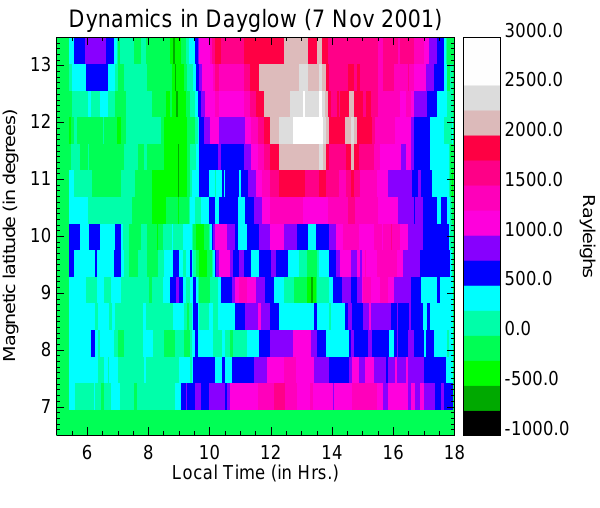
Fig. 8. Same as in Fig. 6 but for 7 November 2001. Notice the strong emissions at around 12 ◦ − 13 ◦ magnetic latitude at 13:00 LT. This represents the optical signature of the development of the EIA in the daytime. This day shows relatively stronger EIA development compared with 5 November (see Fig. 6). Such strong EIA devel- opments are conducive for post-sunset ESF occurrence. Jicamarca digisonde data confirmed the post-sunset ESF occurrence on this night. Enhanced 630.0nm emissions in the afternoon may prove to be the crucial precursors to the post-sunset ESF occurrence.